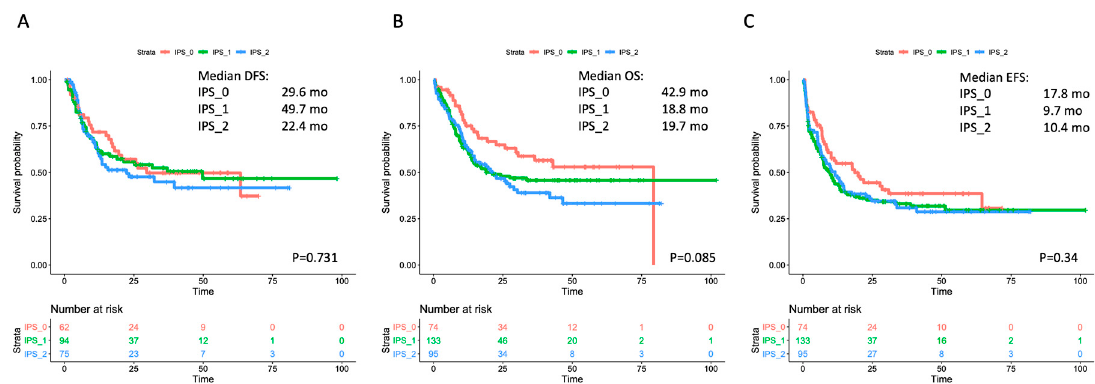
Figure 2. Survival estimates according to IPS in the overall cohort. Major outcomes as assessed by Kaplan-Meier curves for ( A ) disease-free survival (DFS), ( B ) overall survival (OS), and ( C ) event-free survival (EFS) according to number of dysplastic cell lineages by immunophenotypic score (IPS). The curves of patients with no dysplastic lineages (IP_0) are depicted in red; the curves of patients with one dysplastic lineage (IPS_1) are depicted in green, and the curves of patients with both (neutrophil and erythroid) dysplastic lineages (IPS_2) are depicted in blue. Median survival estimates are reported in months. p values were calculated through the log-rank test.